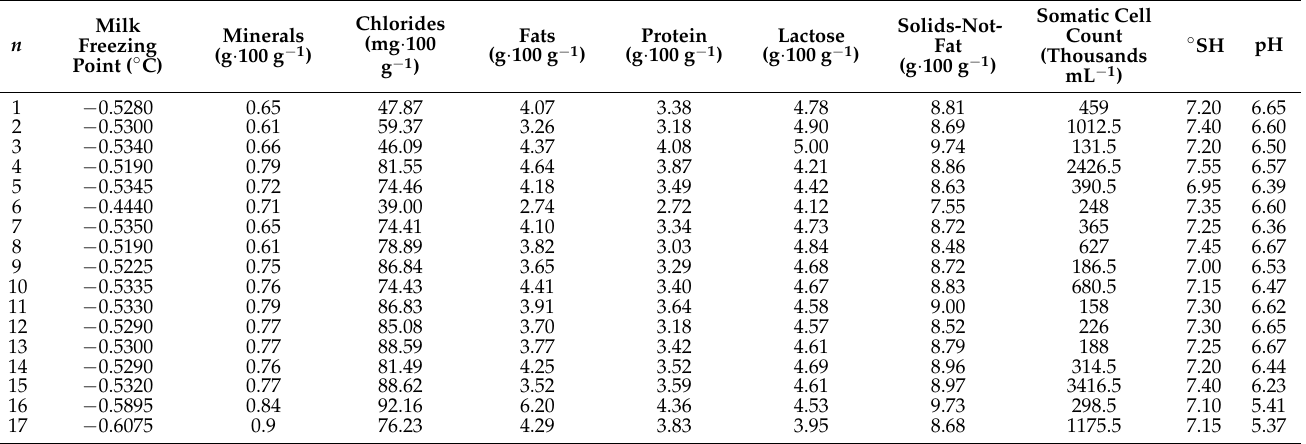
Table 1. Chemical, physical, and biological properties of basic samples of raw cow’s milk from 17 farms in SW